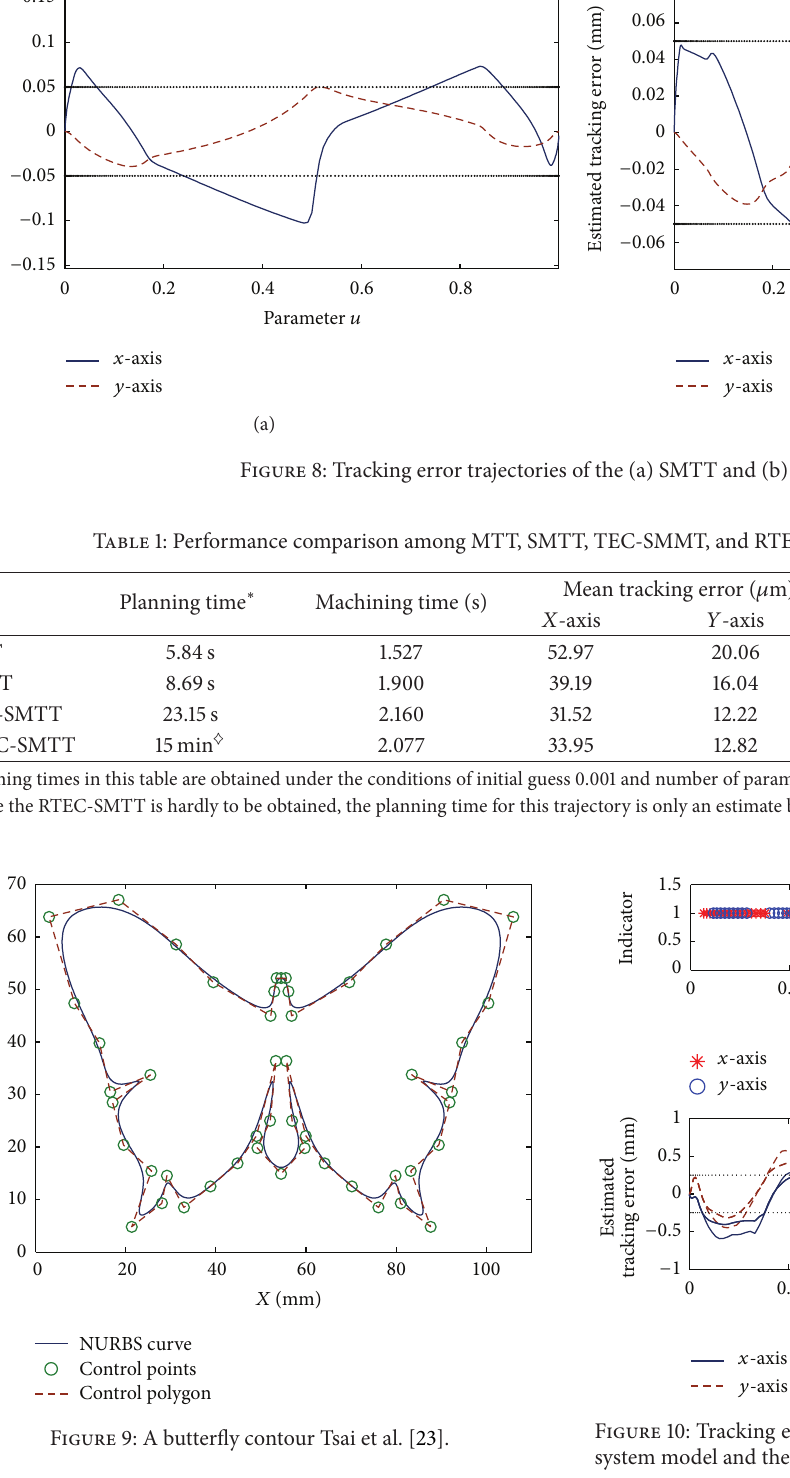
jerk constrained smooth trajectory. The data in Table 2